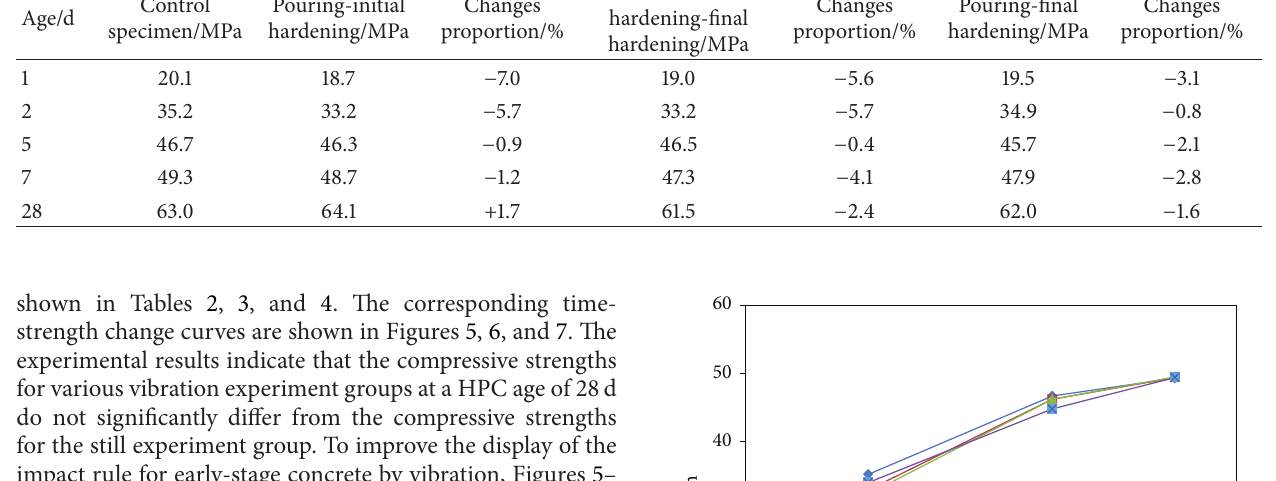
Table 3: Compressive strength and rate of change of HPC specimens with vibration parameters of 4Hz and 3mm. Age/d